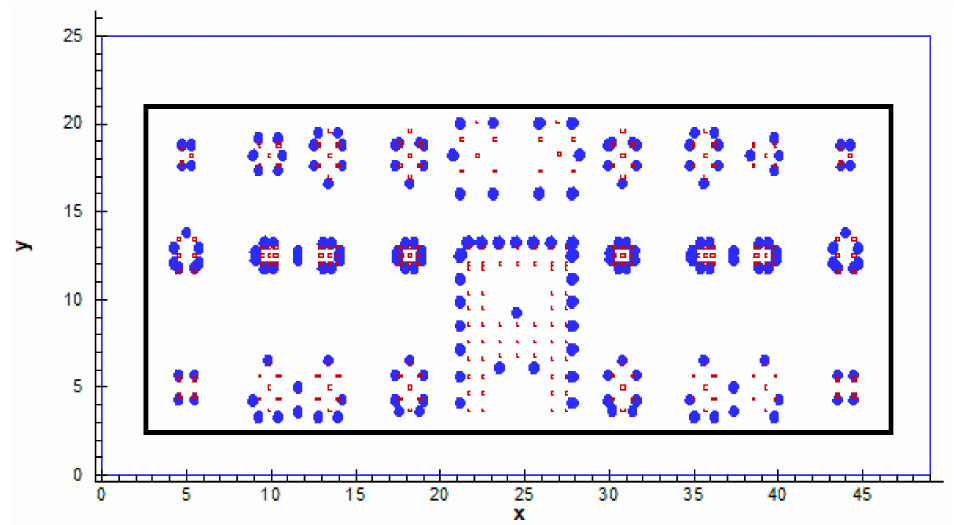
Figure 3. Scheme of the PF under Building I with the piles (red spots) and SCDs (blue